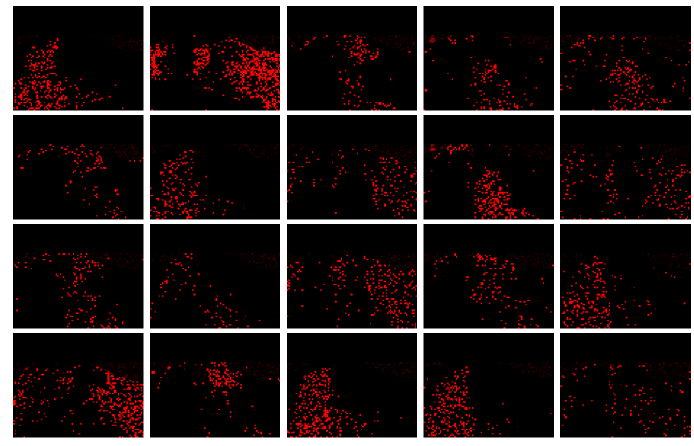
Figure 8. Twenty latent motion regions discovered by RTM-GS. Algorithms 2018 , 11 , x FOR PEER REVIEW